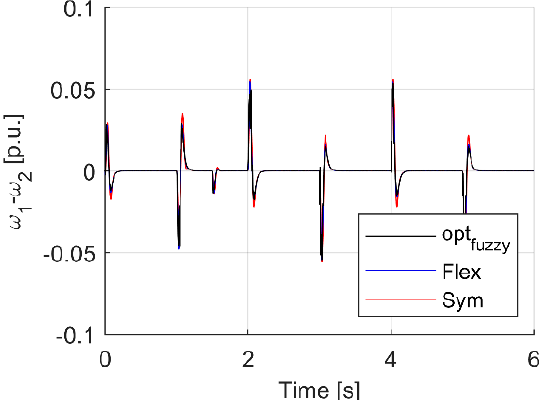
Figure 6. Transients of difference between motor and load speed for analyzed controller cases.